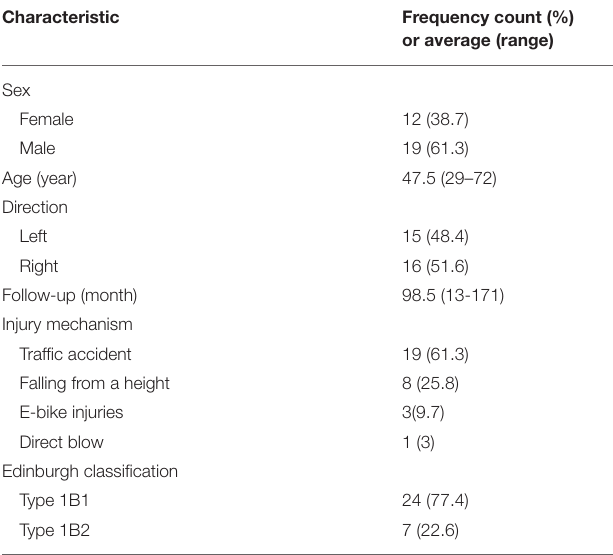
TABLE 1 | Demographic data for the 31 patients with displaced medial-end clavicle fracture.